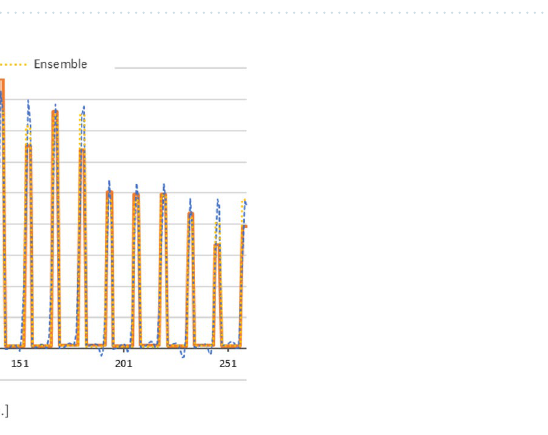
Figure 13. Power Factor PF—RMSE: D-PNN = 0.0516, SMLT (GPR) = 0.0496 [], 12 inputs + Pst + U (D-PNN, 12 inputs + Pst + THDU (SMLT) in the 3rd stage.